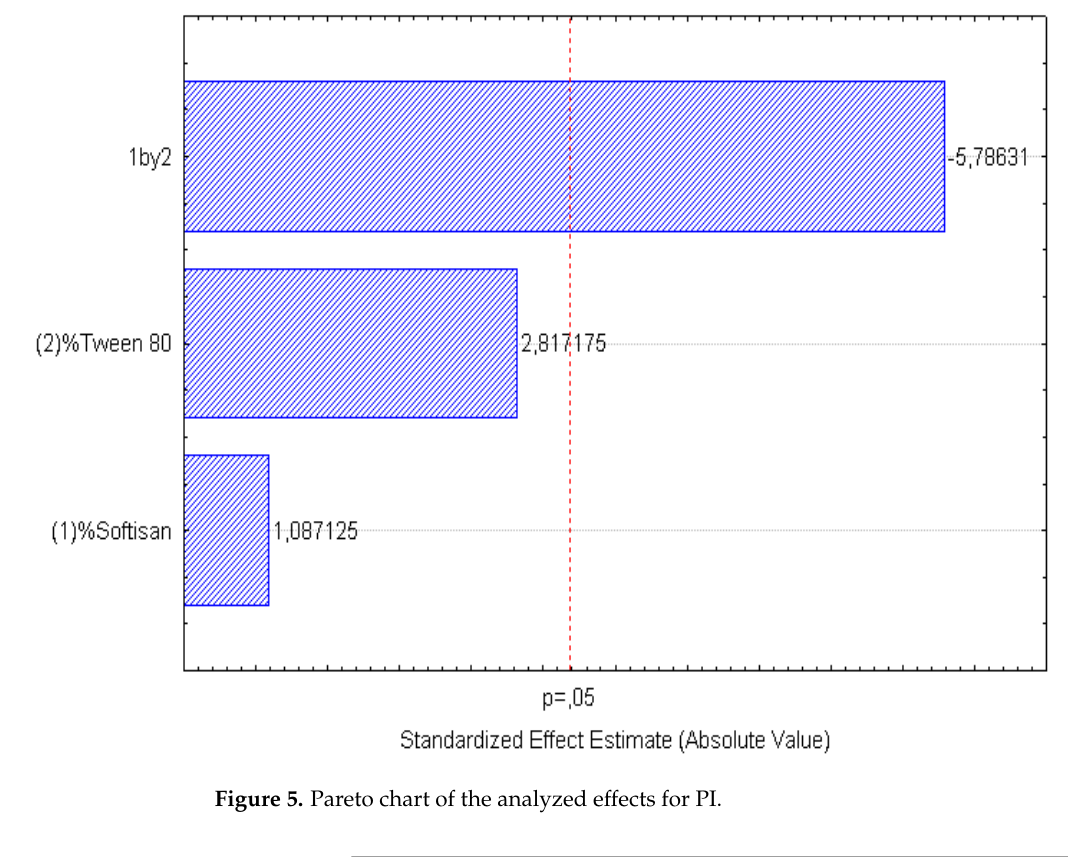
Figure 4. Pareto chart of the analyzed effects for z-Ave.